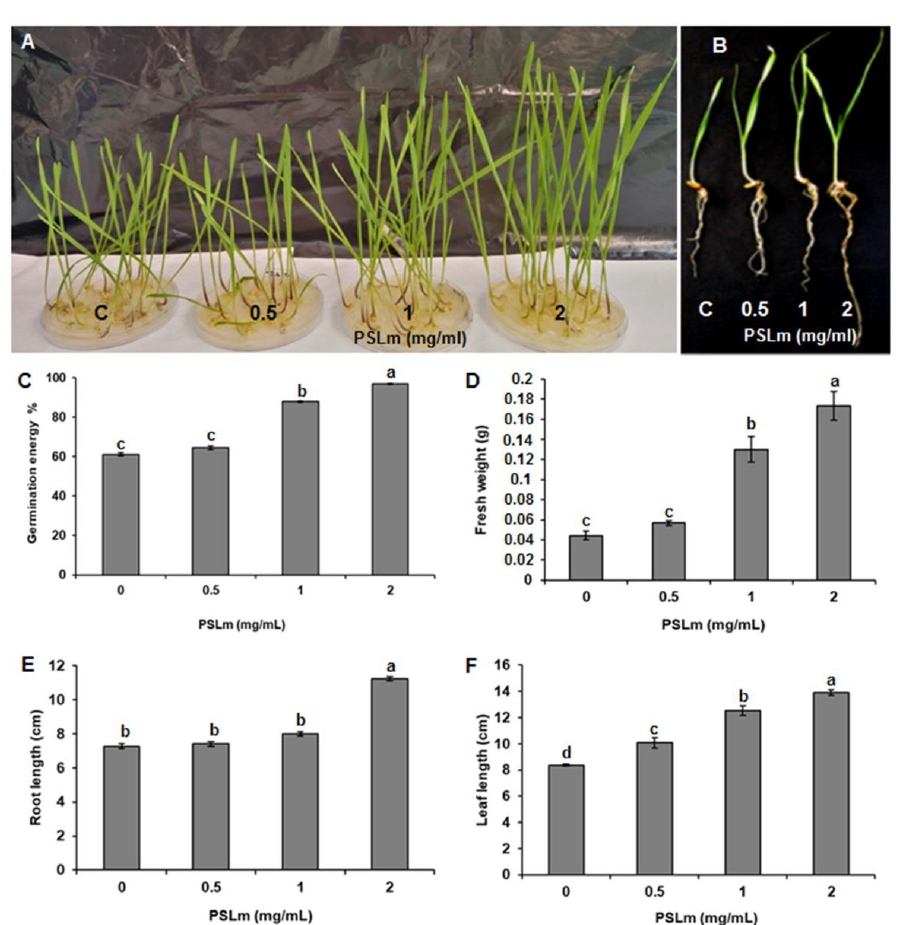
Figure 1. Polysaccharides derived from L. maritima (PSLm) enhanced seed germination and plant phenotypes of durum wheat cv. Karim. ( A , B ) Photographs taken eight days after sowing seeds treated